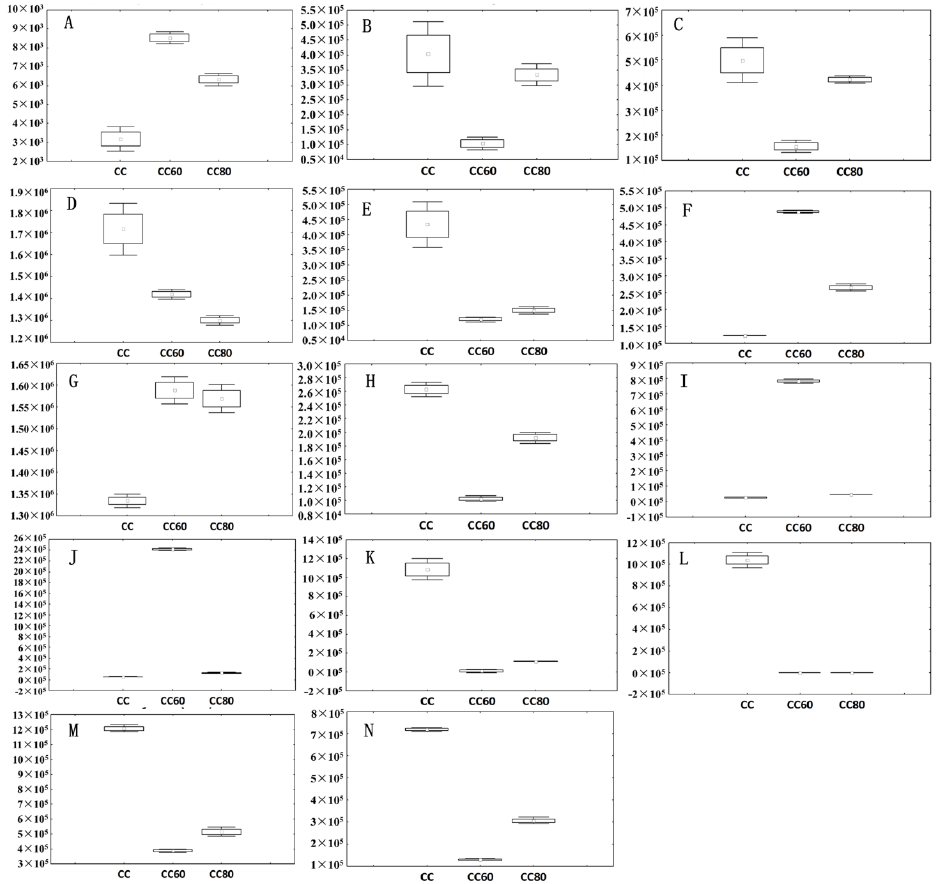
Figure 3. Box and whisker plots of metabolites that were significantly different between the fresh and heated CC juice with dedicated conditions analyzed by UHPLC-LTQ-Orbitrap-MS/MS. The Y-axis of the box and whisker plots indicates the peak area of each metabolite (Square, mean; box, standard error; whisker, standard deviation). ( A ) N-(1-Deoxy-1-fructosyl)leucine, ( B ) Quercetin-glucosylgalactoside-glucoside or Quercetin-triglucoside, ( C ) Kaempferol-di-glucoside or Kaempferol-sophoroside, ( D ) Feruloyl-galactaric acid, ( E ) Kaempferol-sophoroside-glucoside, ( F ) Quercetin-di-glucoside, ( G ) Sinapinic acid-O-glucuronide isomer, ( H ) Kaempferol diglucoside- (feruloylglucoside), ( I ) Quercetin-hexoside, ( J ) Kaempferol-glucoside, ( K ) LysoPE (18:2), ( L ) LysoPC (18:2), ( M ) LysoPE (16:0), and ( N ) LysoPC (16:0).